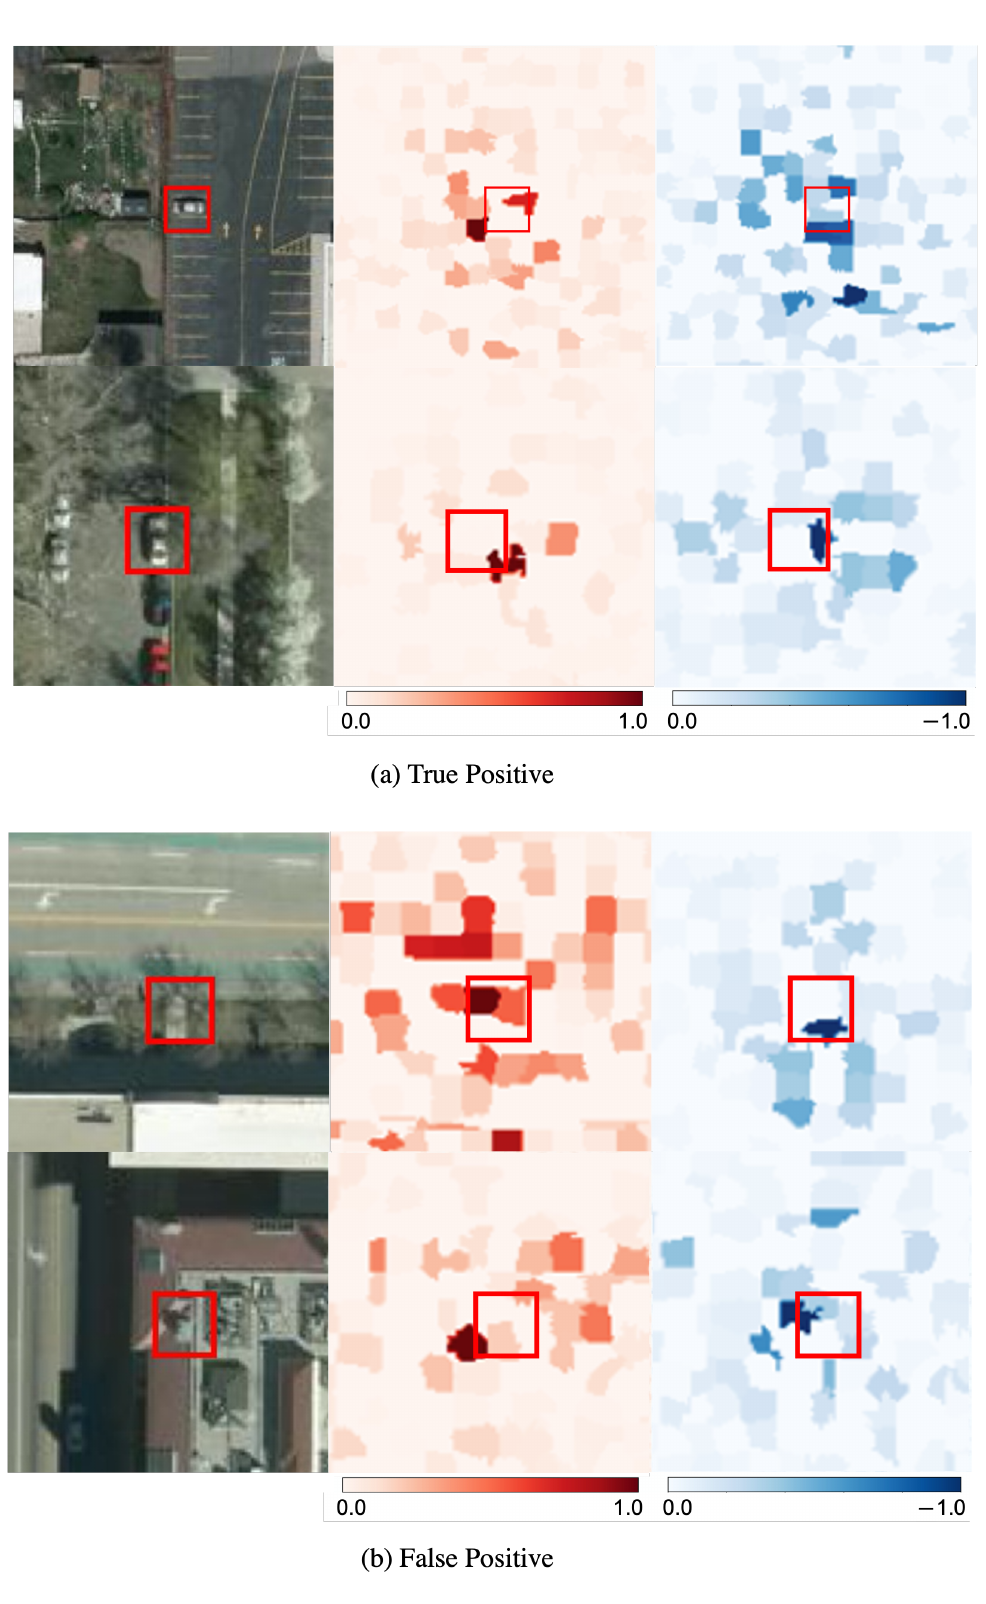
Figure 7. Visualization results of positive outputs using E2X [21]. The left image shows the inferred results, the center image shows the distribution of positive values, and the right image shows the negative